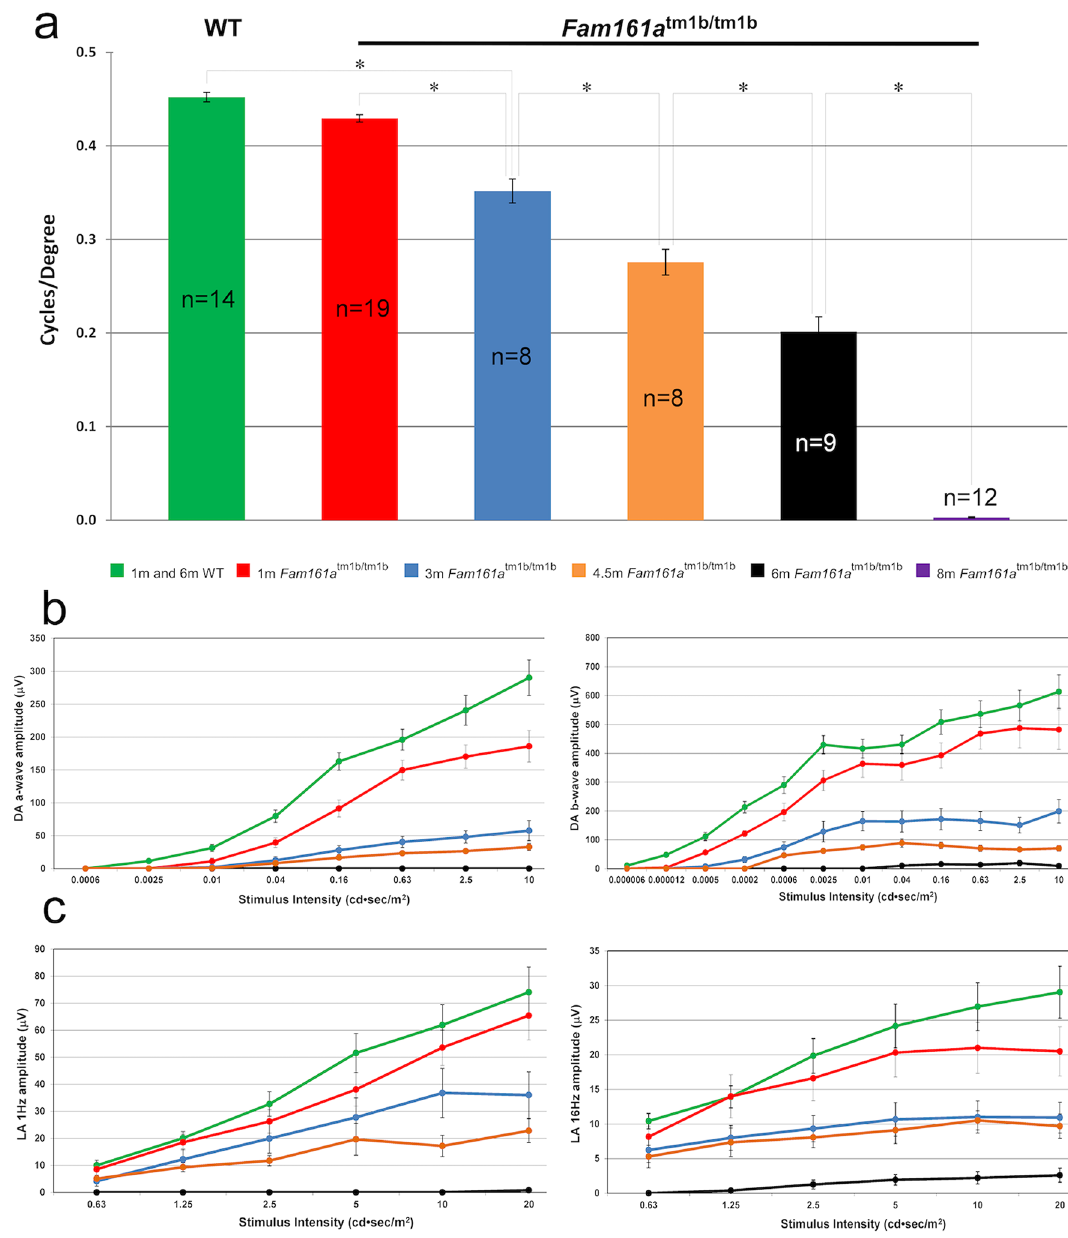
Figure 3. Retinal function in Fam161a tm1b/tm1b . ( a ) Visual acuity in WT (average results of 7 mice at the age of 1 months and 7 mice at the age of 8 months) and mutant mice in different ages (represented by the different colors). ( b ) A-wave and B-wave ERG responses in dark adapted conditions of WT and Fam161a tm1b/tm1b mice at different ages. The green line represents WT mice at different ages (average results of 10 mice at the age of 1 months and 9 mice at the age of 8 months). Red, blue, orange and black lines represent mutant mice at ages 1, 3, 4.5 and 6 months respectively. ( c ) ERG responses in light-adapted conditions (1 Hz and 16 Hz stimulus) of WT and Fam161a tm1b/tm1b mice at different